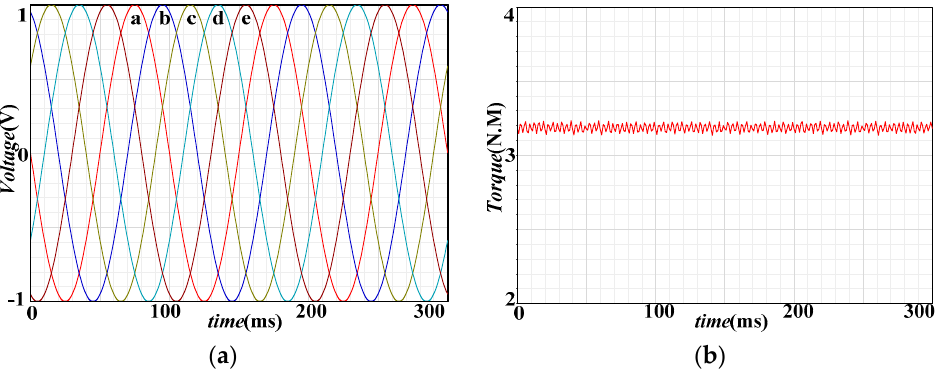
Figure 8. Current and torque waveforms under normal condition: ( a ) phase current; ( b ) torque.